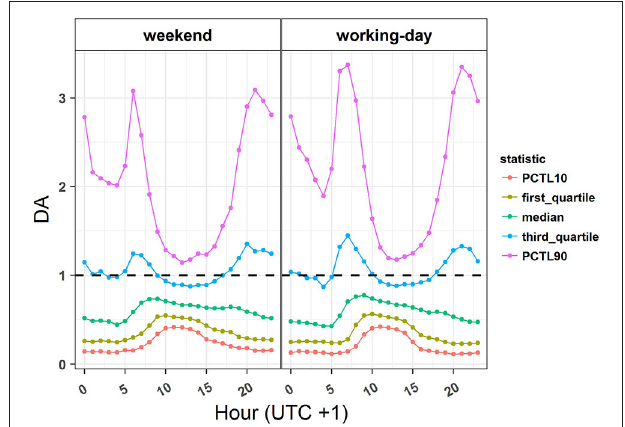
FIGURE 3 | Mean diurnal cycles of 10, 25, 50, 75, and 90th percentile Damköhler numbers depending on traffic volume, averaged over the period